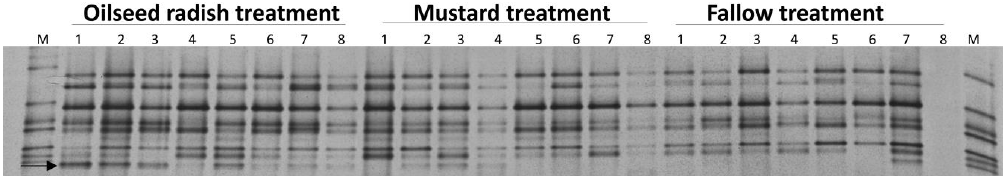
Figure 4. Gross Munzel, vap1 gene-based DGGE fingerprints of Heterodera schachtii population from DNA of 10 pooled cysts per replicate sample (the number above each lane refers to the replicate number for each treatment), and electrophoretic separation by DGGE. M: marker of cloned vap1 variants. The arrow indicates the vap1 band whose intensity under oilseed radish was higher than mustard and fallow treatment.